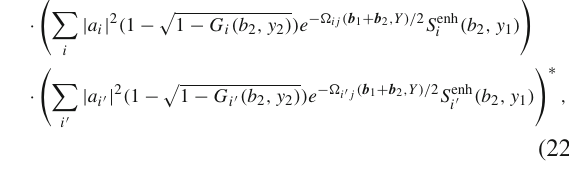
Fig. 4 The t dependence of the elastic proton–proton (proton- antiproton) cross sections in the S p ¯ p S, Tevatron and the LHC colliders energy range. The parameters of model were tuned as described in Sect. 4. The data are taken from [33–46]. The poor description of the data at the larger values of − t can be improved by using a more detailed G–W parameterization, but this is not relevant to our study